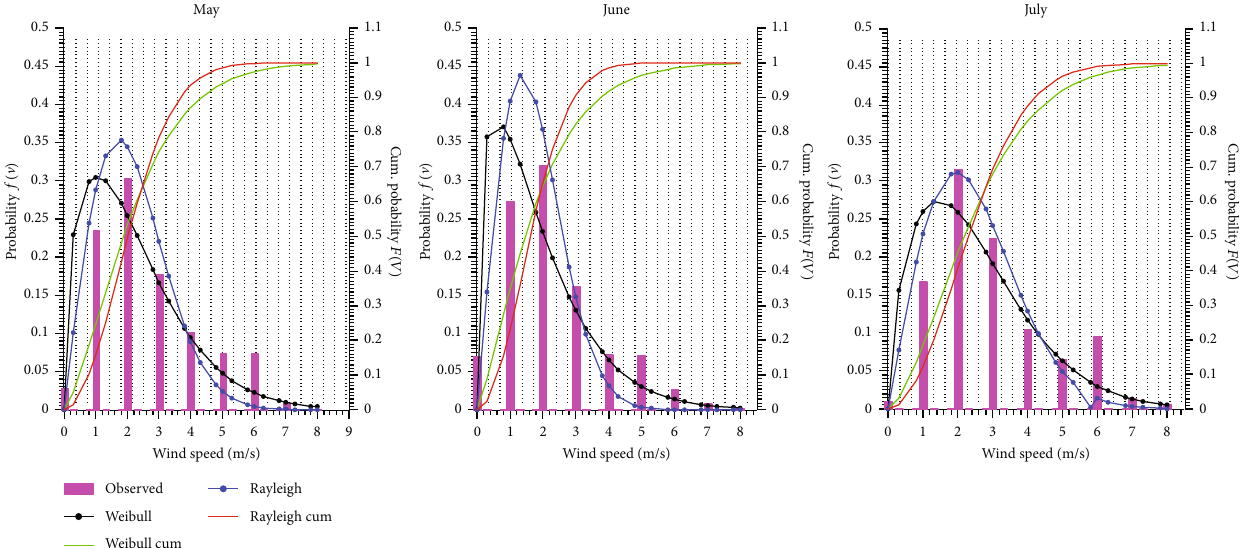
Figure 8: Observed histogram, Weibull, and Rayleigh probability and cumulative curves for May, June, and July (2018) (Tables 30 – 32 in Supplementary Materials).